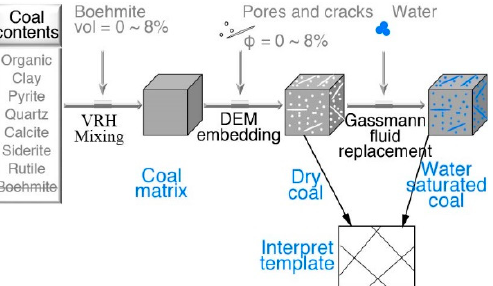
12 of 16 Figure 8. The cross-plot of bulk modulus vs. modulus ratio of Monte Carlo simulated realizations for different mineral-rich coals. Group one is quartz-rich cores, group two is boehmite-rich cores, and group three is clay-rich cores. As measured cores, the cross-plot of realizations has group distribution characteris- tics and similar variation trends. Dry-state realizations are in the lower half, and water- saturated realizations are in the upper half. The gap between dry and water-saturated states is more significant than between groups in a dry or water-saturated state. After fluid replacement, the magnitude and variation scope of scattering points are magnified and follow the marked fluid replacement (FR) trend. Therefore, the cross-plot of bulk modulus vs. modulus ratio can distinguish realizations into different groups as measured cores did and can be used to qualitatively interpret mineral-rich and saturation states. 5.2. Interpretation Template for Boehmite Content To quantitatively interpret boehmite (gallium) contents, the authors propose a work-